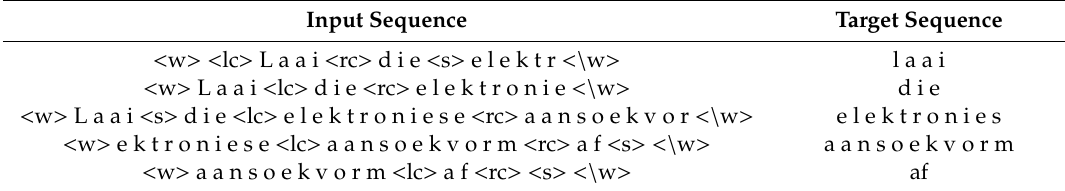
Table 4. Input and target format for the lemmatization model with context size = 10 for the